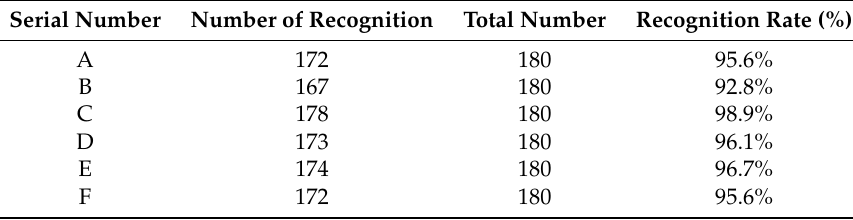
Figure 8. Experimental diagram. Table 3. The decoding of six